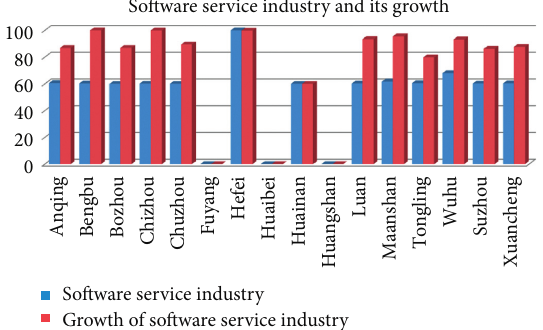
Figure 3: Software service industry and its growth.